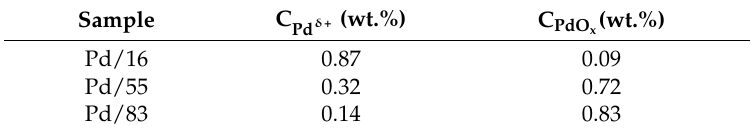
Table 4. Amounts of dispersed Pd ions and aggregated palladium oxide in each sample.